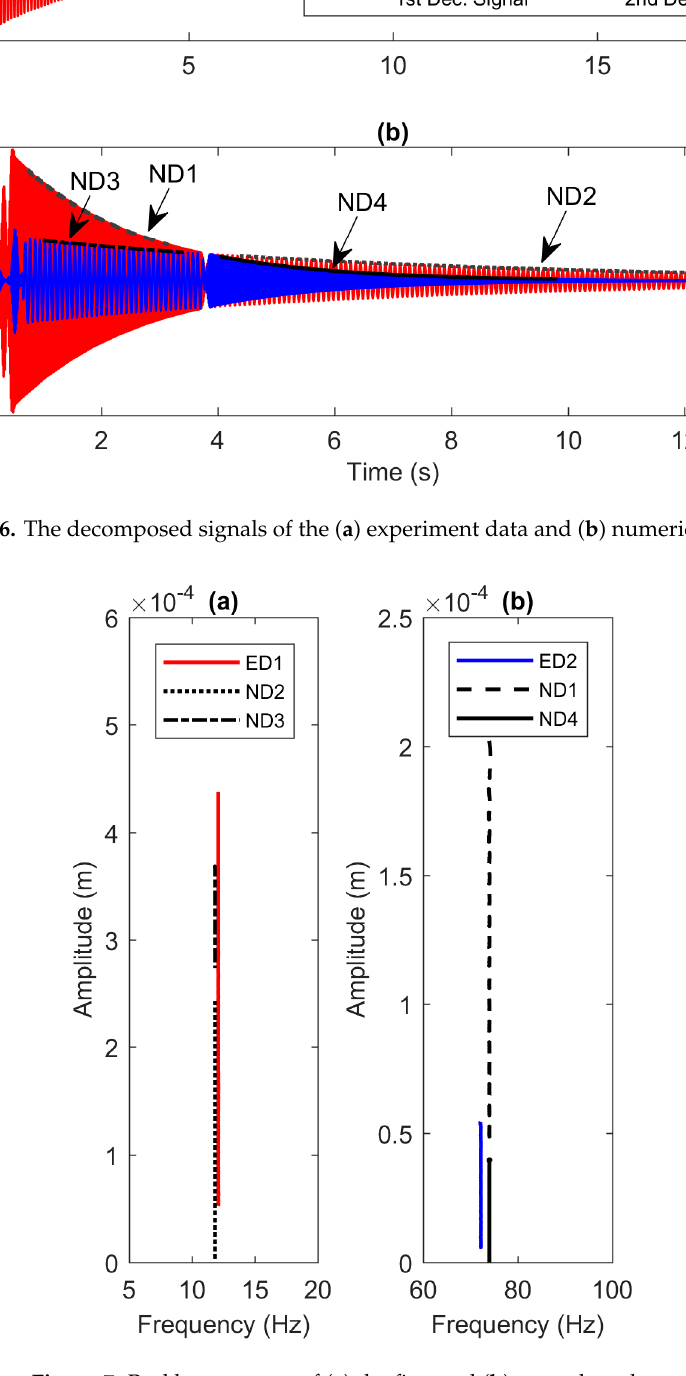
Figure 7. Backbone curves of ( a ) the first and ( b ) second modes.